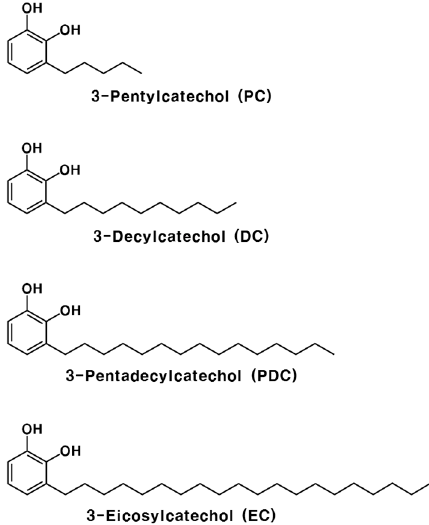
Figure 1. Structures of synthesized urushiol derivatives.